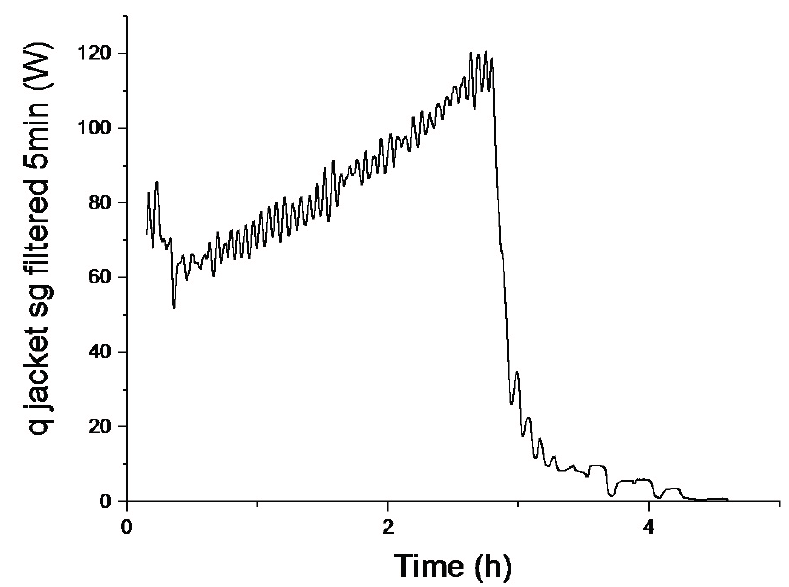
Figure 6. Filtering using a moving-average Savitzky-Golay filter with a filter time of 300 s (the same data set as shown in Figure 5 are